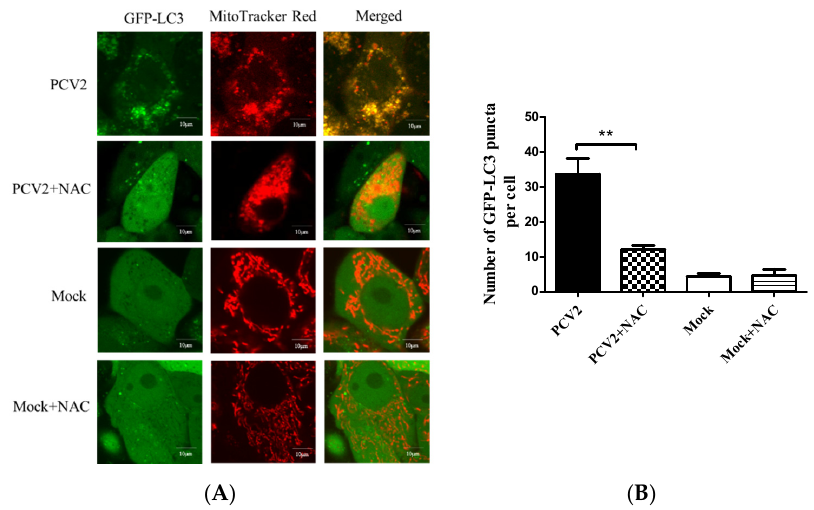
Figure 5. Colocalization of the EGFP-LC3 punctae and MitoTracker induced by PCV2 was inhibitable using a ROS-scavenger N-acetyl-L-cysteine (NAC). The PK-15 cells stably expressing EGFP-LC3 in Petri dishes were infected with PCV2, treated with 10 mM NAC at 2 hpi or untreated, and subjected to further incubation for 46 h. ( A ) Cells were treated with 100 nM MitoTracker Red for 15 min in the dark. Representative confocal images showing the colocalization of MitoTracker Red and EGFP-LC3 punctae in the cells with or without (Mock) PCV2 infection. Scale bars: 10 µ m. ( B ) Average numbers of colocalization of EGFP-LC3 and MitoTracker Red punctae per cell from at least 50 cells. Bar chart ( B ) shows the mean ± SEM of three independent experiments. ** p < 0.01.